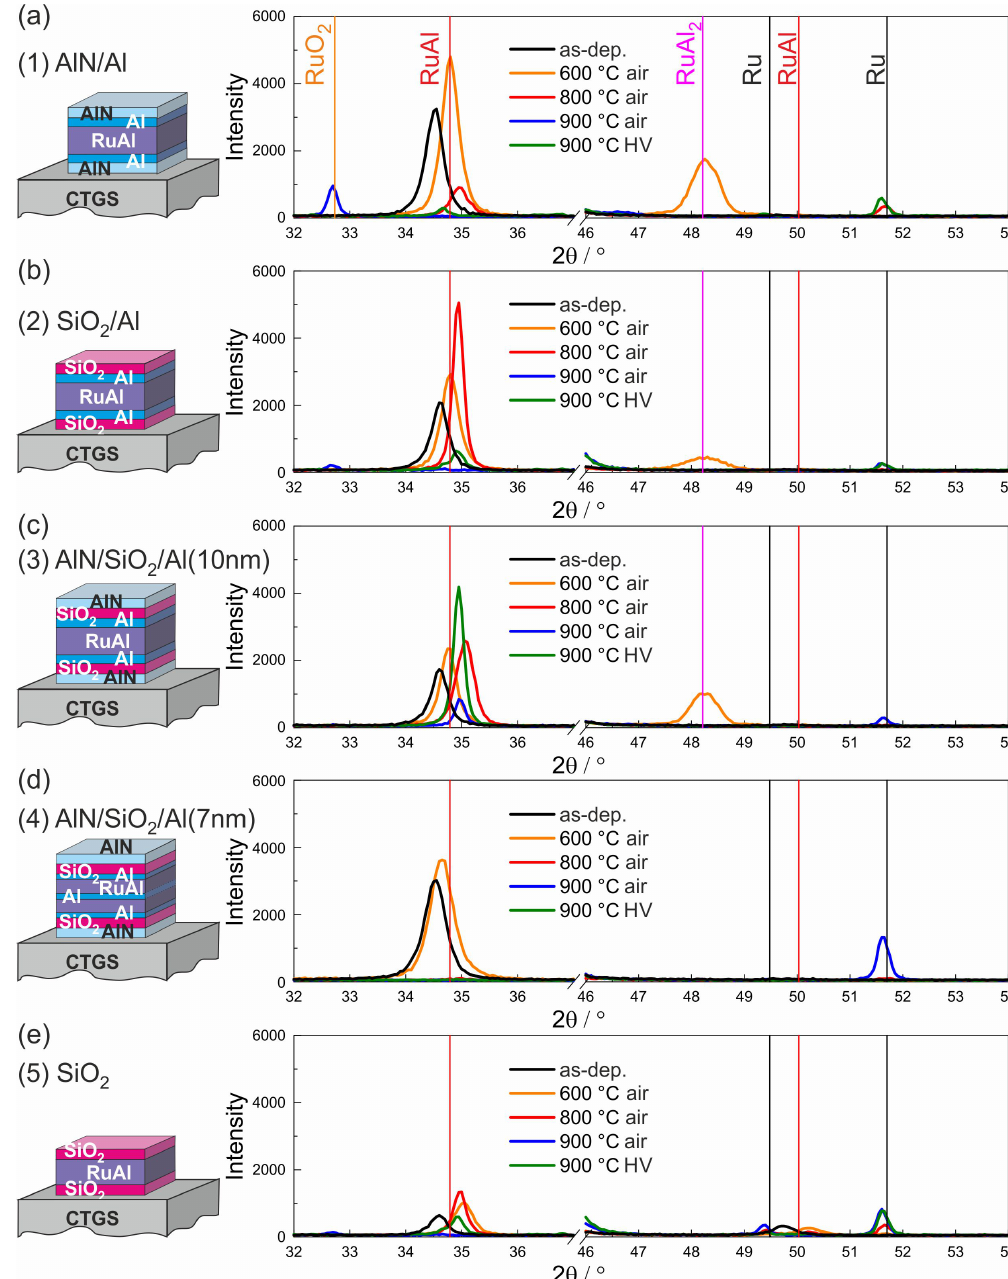
Figure 7. Results of the XRD measurements (Bragg–Brentano, Co-K α ) for the samples with the different cover and barrier layers on CTGS substrates: ( a ) (1)-AlN/Al, ( b ) (2)-SiO 2 /Al, ( c ) (3)-AlN/SiO 2 /Al(10 nm), ( d ) (4)-AlN/SiO 2 /Al(7 nm), and ( e ) (5)-SiO 2